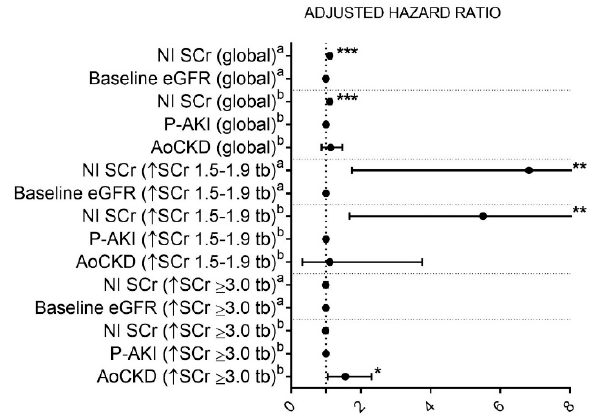
Figure 4. Adjusted hazard ratios (95% confidence interval) for death. NI: Net increase. SCr: Serum creatinine. eGFR: Estimated glomerular filtration rate. P-AKI: Pure acute kidney injury. AoCKD: Acute-on-chronic kidney disease. Tb: Times baseline. a: Models including SCr NI, baseline eGFR, age,